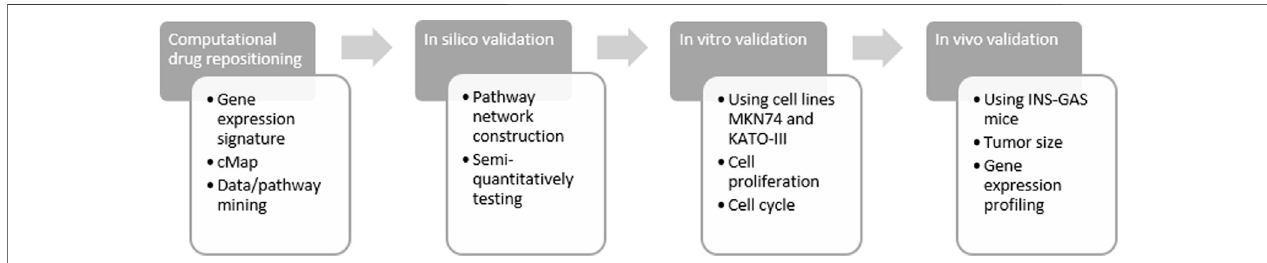
FIGURE1| Flowchartofstudydesign. Computational drugrepositioningwascarried outbyusinggeneexpression signaturesrepresentinggastriccancerofboth patients and mouse model and connectivity map (cMap) and data/pathway mining with the Ingenuity Knowledge Base. Validation included in silico , in vitro and in vivo methodsofivermectintreatment.TherationaleofusinghumansamplesofGC(withoutivermectintreatment)was i )toperformcomputationalpredictionanddatamining and ii ) to make a comparison with the animal model in order to demonstrate that the animal study could be relevant in the design of clinical trial of ivermectin in the